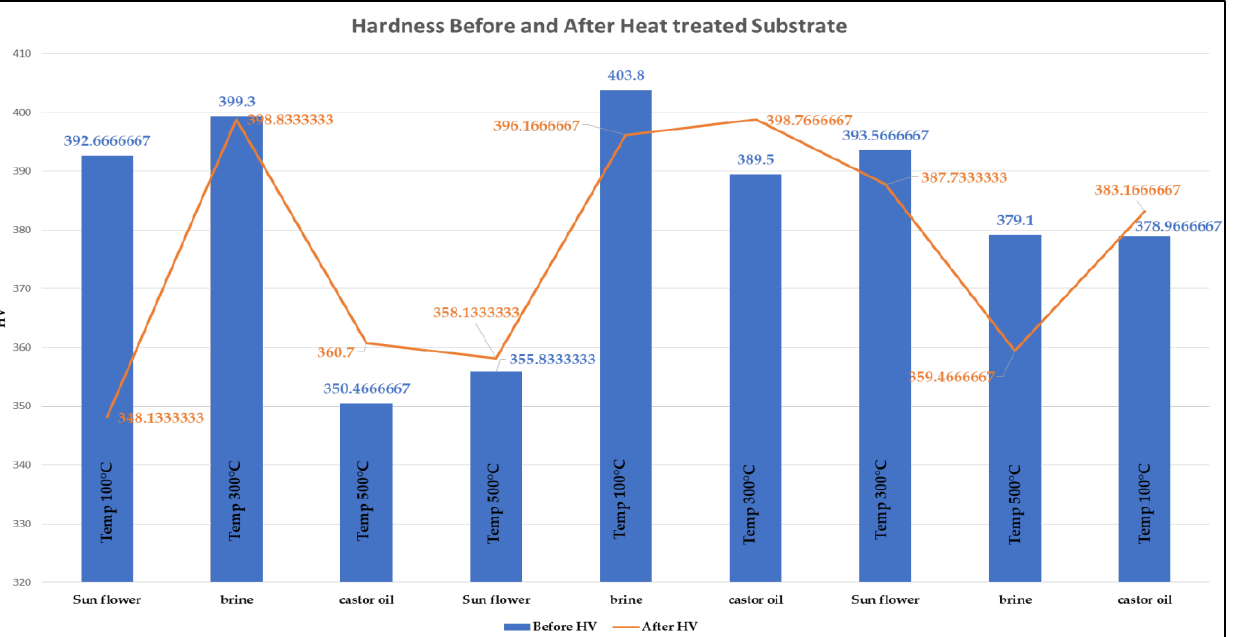
Figure 2. Experimental Graph .